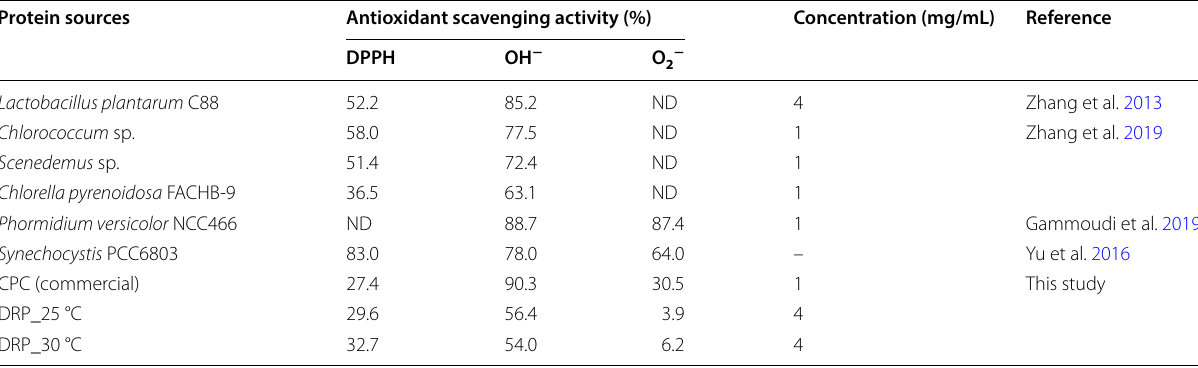
ND means not-determined